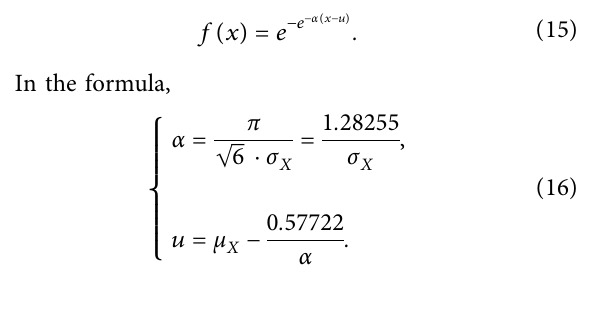
x × L : distance of 3